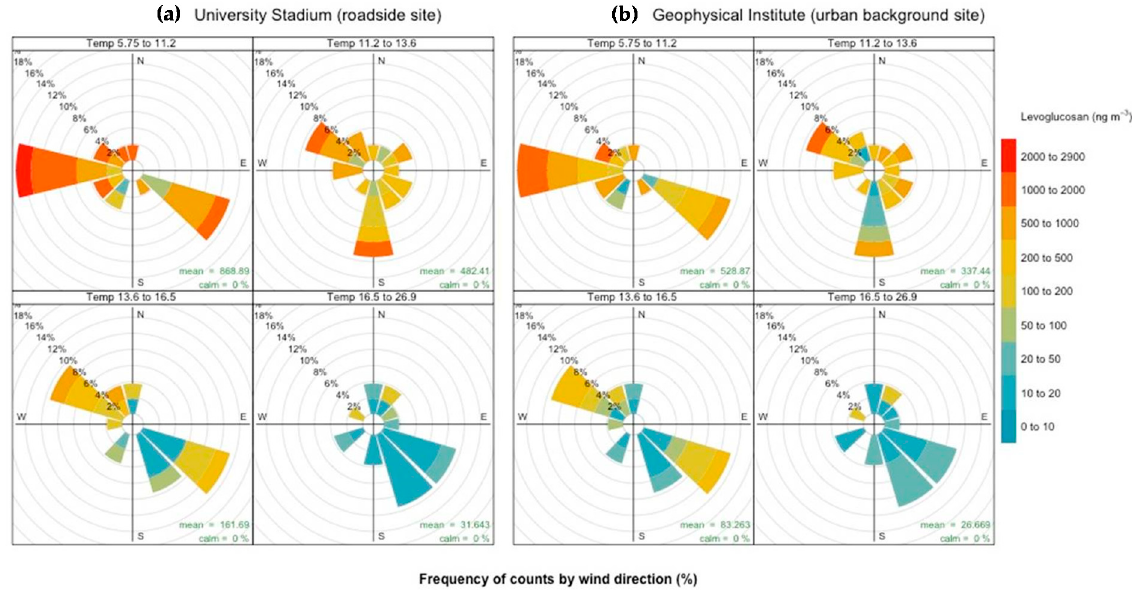
Figure 3. Pollution roses for levoglucosan concentrations conditioned by temperature, for each sampling site: University Stadium (roadside site) ( a ) and Geophysical Institute (urban background site) ( b ).